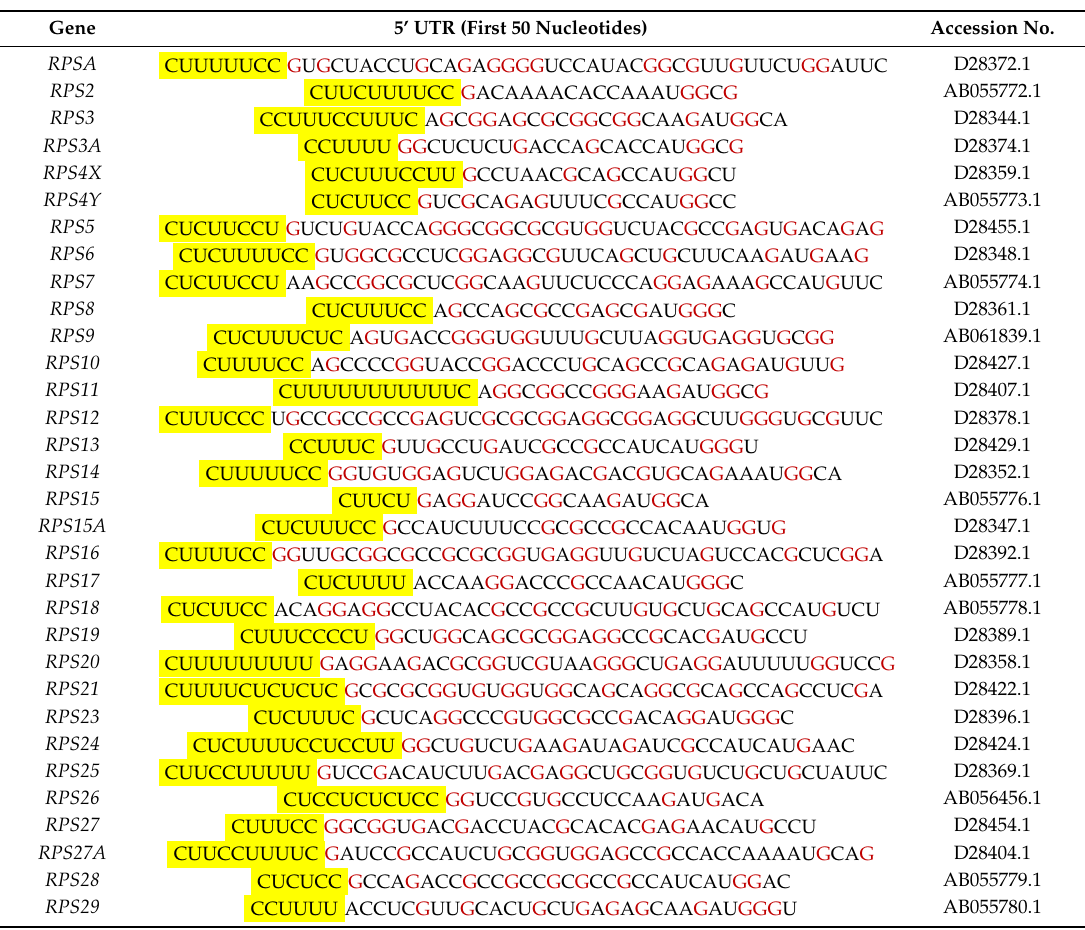
Table A1. List of transcripts containing 5’ TOP motifs. The first 50 nucleotides of each TOP transcript. The 5’ TOP motif is highlighted in yellow and guanines are in